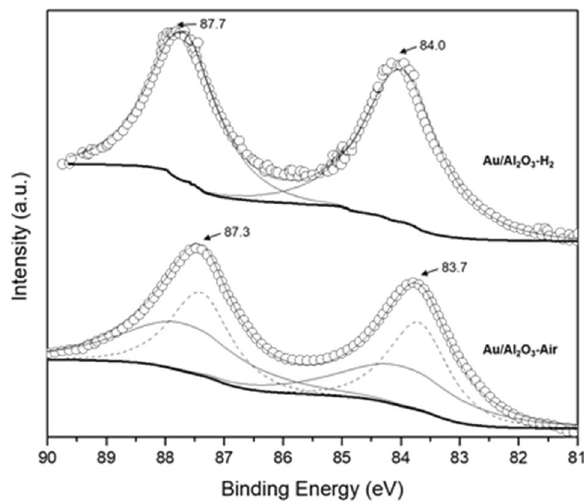
Figure 5. XPS spectra of γ-Al 2 O 3 and Au/Al 2 O 3 catalysts for Au 4f.